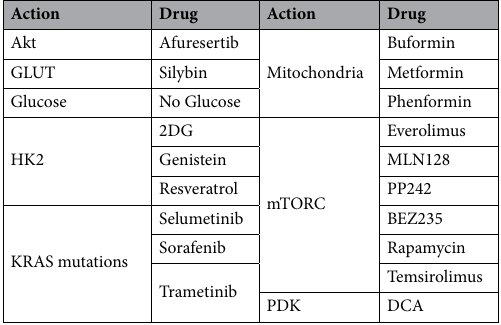
Table 2. Actions of studied drugs on the glycolytic pathway.